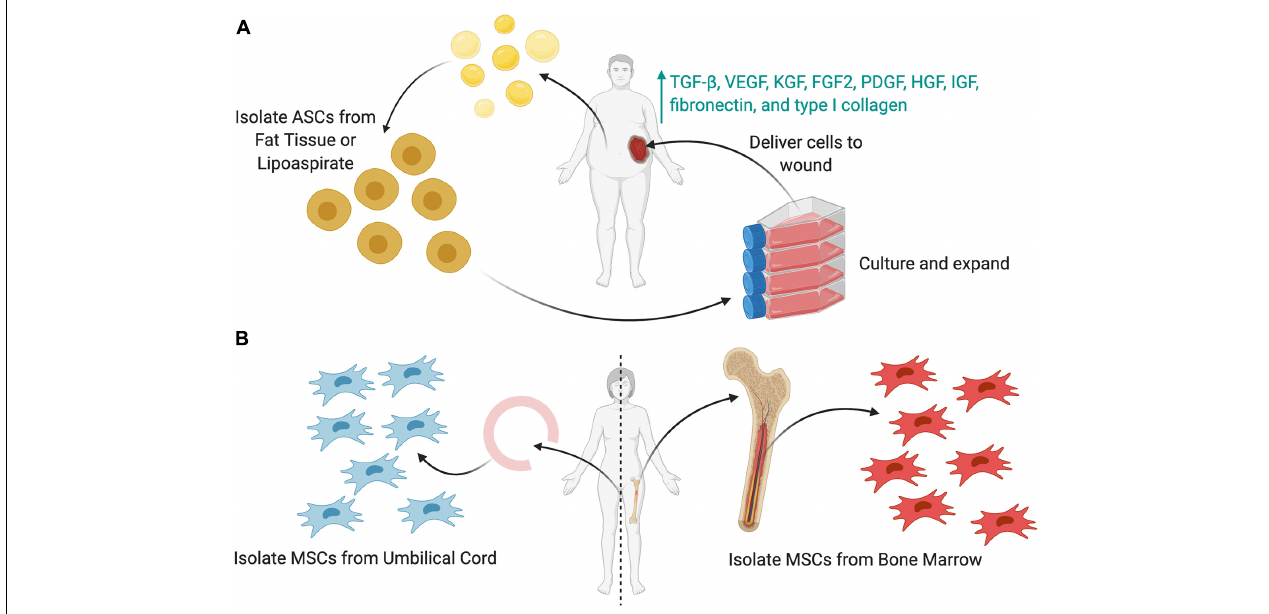
FIGURE 3 | Sources of stem cells to be used as cellular therapies. (A) Adipose-derived stem cells (ASCs) can be harvested from either lipoaspirate or fat tissue. These cells (or MSCs) can then be cultured in vitro , expanded in number, and then delivered to the wound as a cell therapy. To enhance the cell delivery, several delivery techniques (shown later) may be used. (B) Mesenchymal stromal cells (MSCs) can be harvested from either the umbilical cord or the bone